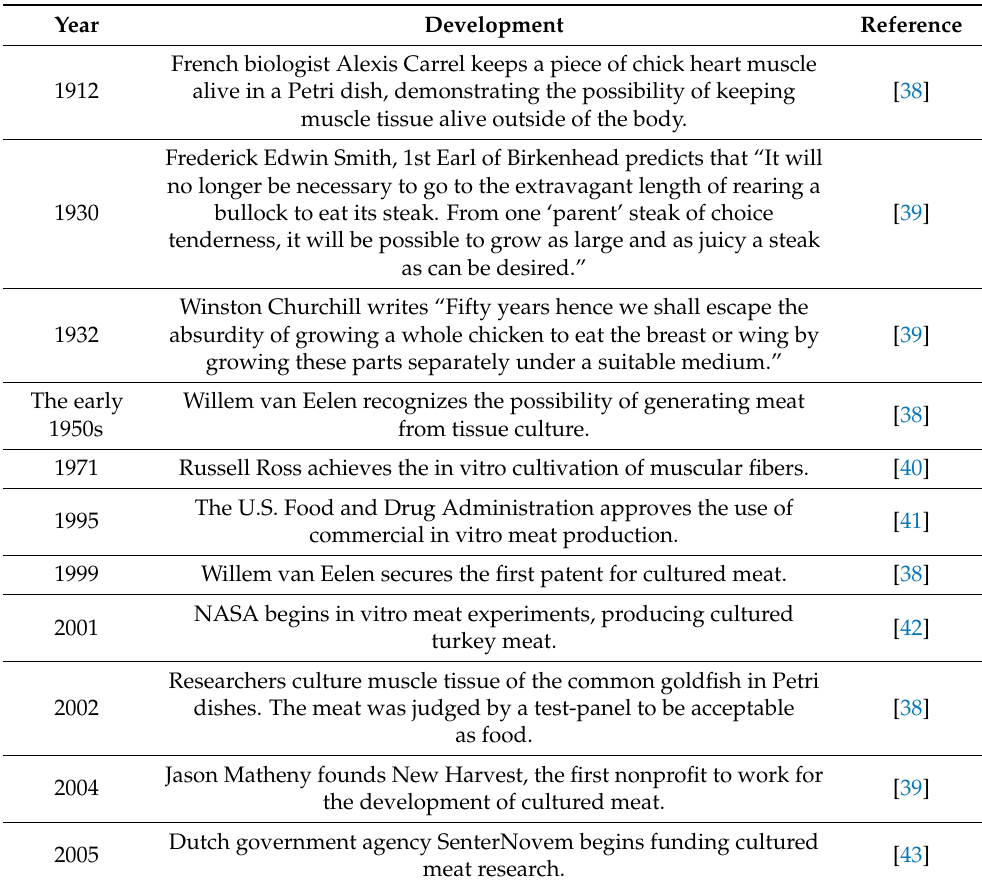
Table 3. Historical milestone of in vitro meat